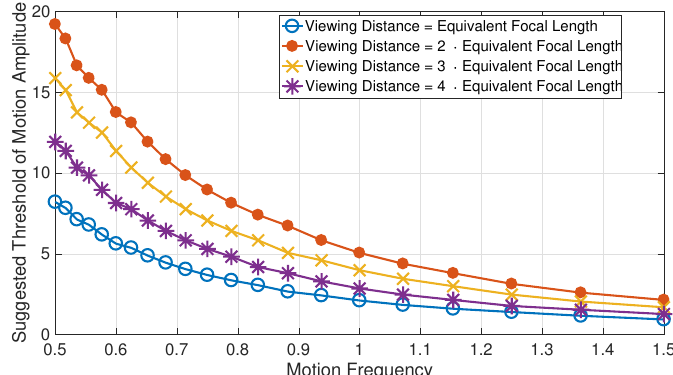
Figure 12. Suggested threshold to achieve VE = 0.8 under different motion frequencies and viewing